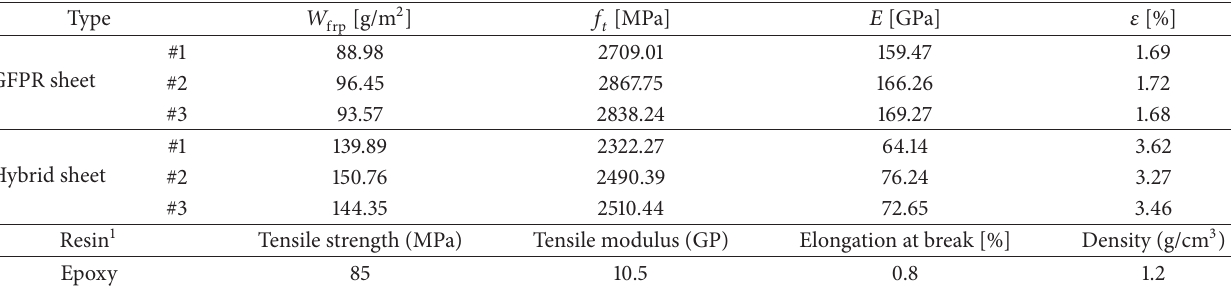
Table 2: Material properties of FRP and resin.